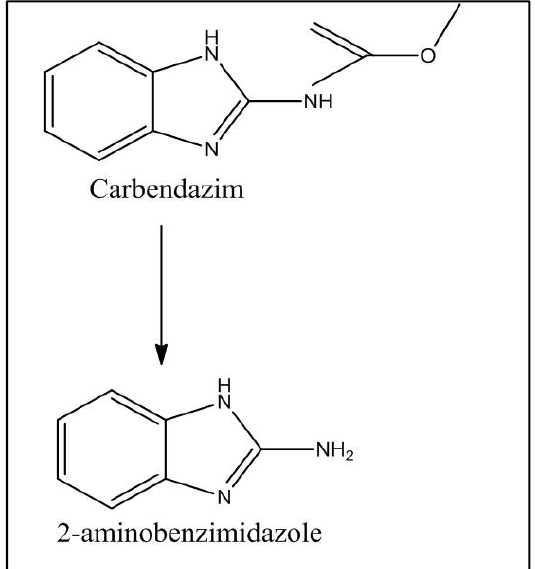
Figure 6. Bacterial degradation pathway of carbendazim by Pseudomonas [209].